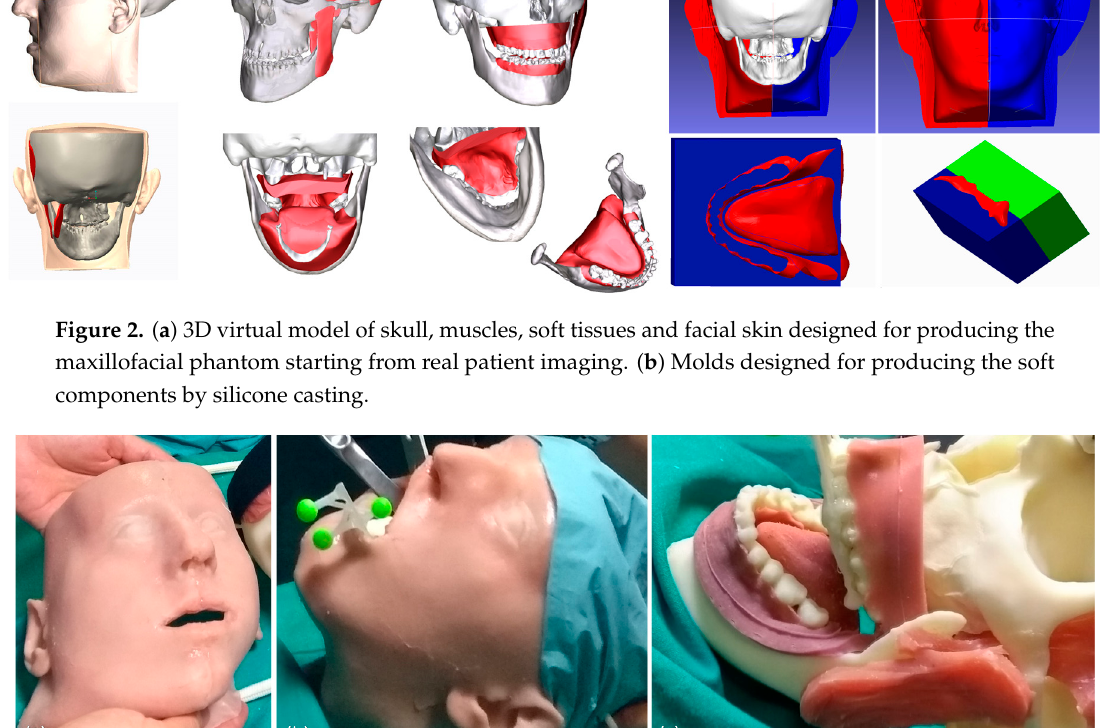
Figure 4. The virtual ( a ) and the 3D-printed model ( b ) of the task-oriented maxillofacial tracker designed for providing optimal tracking and registration during Le Fort 1 osteotomy task.